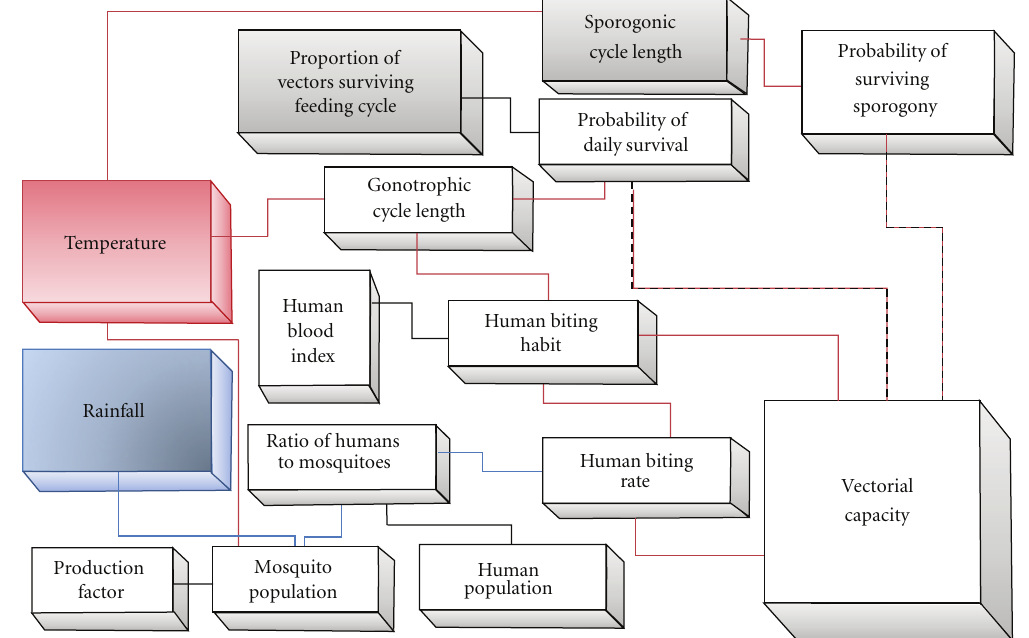
Figure 1: Diagrammatic representation of “expanded” vectorial capacity (VCAP)